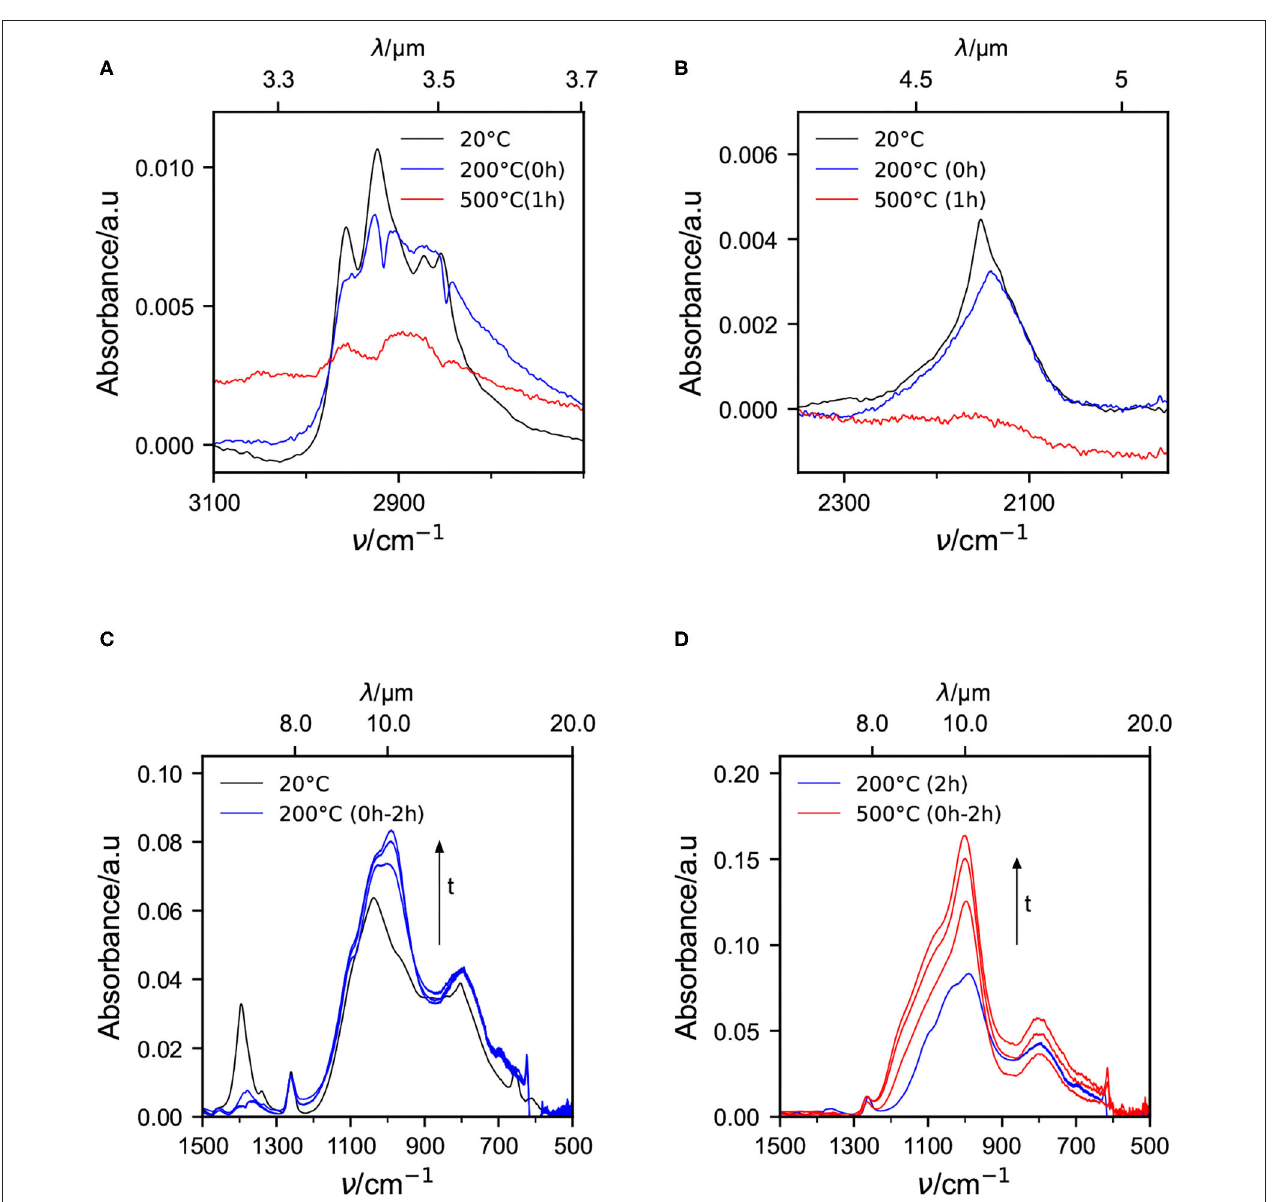
FIGURE 3 | Evolution of the most interesting bands presented in Figure 2 with time at 200 and 500 ◦ C. For each temperature the presented spectra are recorded at t = 0, 1, 2 h. The spectrum at 20 ◦ C is also plotted for